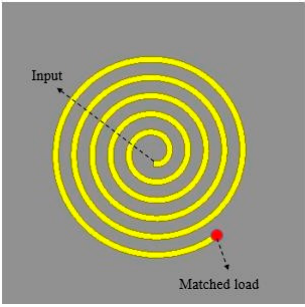
Figure 19. Structure of the array antenna unit.